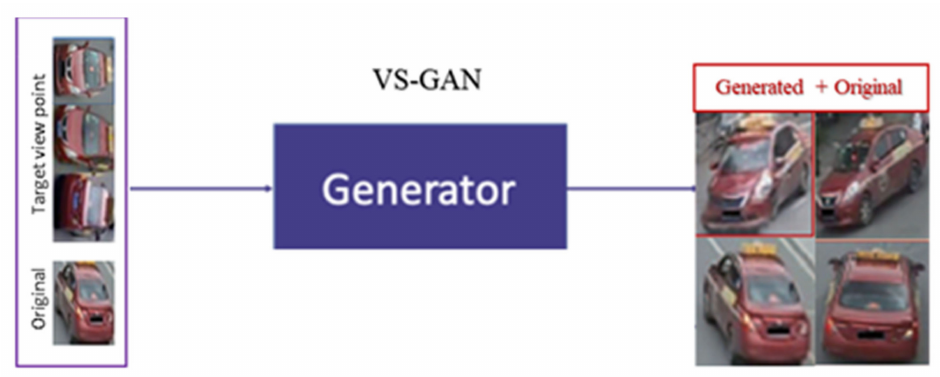
Figure 13. Overview of deep feature representations guided by the meaningful